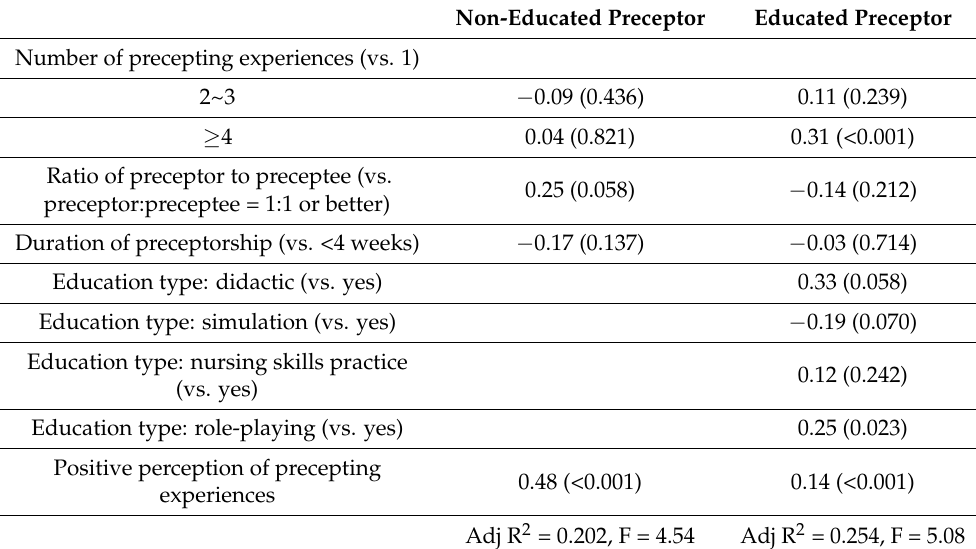
Table 5. Factors influencing clinical teaching behavior based on whether the nurse was educated for a preceptor role ( n =